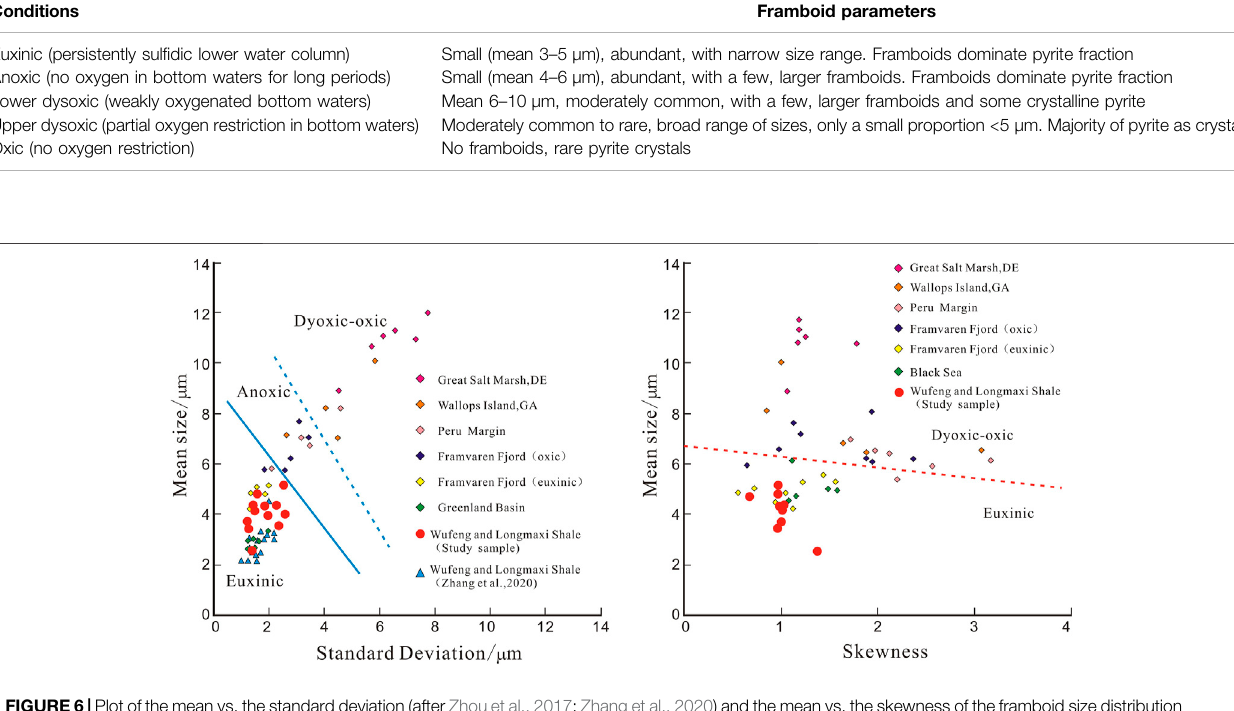
Frontiers in Earth Science |